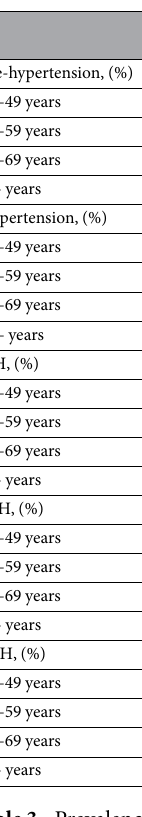
Table 3. Prevalence of hypertension and subtypes in 2000 and 2010. ISH, isolated systolic hypertension; IDH, isolated diastolic hypertension; SDH, systolic-diastolic hypertension. Overall rates were standardized by age & sex. Statistical comparisons for the trend of prevalence over age groups are from the Cochran-Mantel-Haenszel test. Comparisons between surveys for total prevalence of subtypes are from Pearson chi square tests. P value for trend are for both years 2000 and 2010. a P < 0.05, comparison between 2000 and 2010 by sex. b P < 0.05, comparison between men and women in